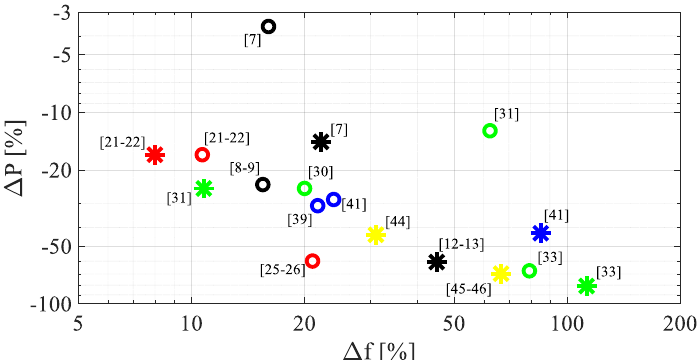
Figure 27. Summary of the tuning performance of the analyzed MTTs. All the asterisks represent ΔP R (Δf R ), all the circles represent ΔP L (Δf L ). The various MTTs are identified with different colors. Black for “Magnetic Forces Based MTTs”, red for “Piezoelectric Actuators Based MTTs”, green for “Axial Loads Based MTTs”, blue for “Variable Reluctance Based MTTs” , and yellow for “Variable Center of Gravity MTTs”.